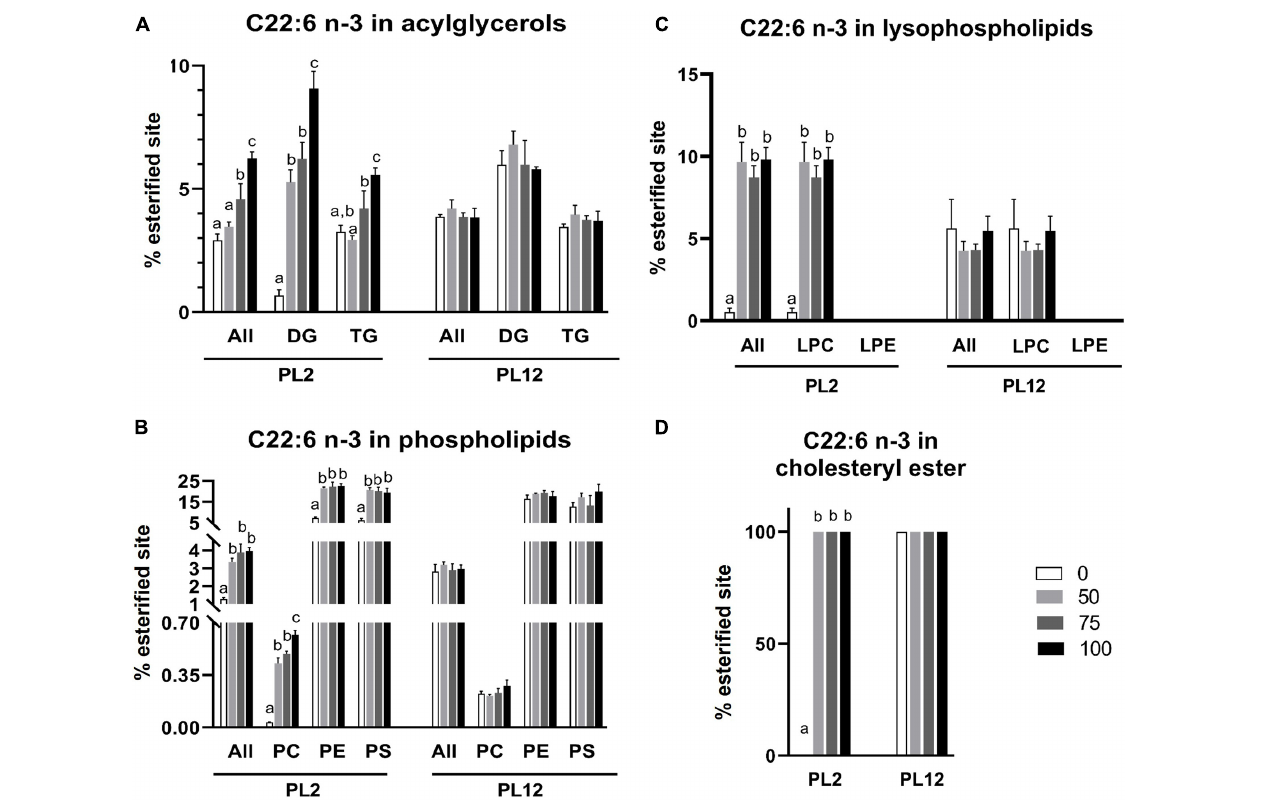
FIGURE 6 | Analysis of the 22:6 n-3 fatty acid distribution in lipid classes and subclasses by LC-HRMS. Percent of meal replacement was the percent of meals for which TW was replaced by AL. Percent esterified site is the percent of sites esterified with 16:0 compared with all the sites esterified with any types of fatty acids on the backbone. Error bars represent standard errors ( N = 3). Statistical analyses of the PL2 and PL12 data sets were performed separately, using ANOVA. Significant differences among subsets of treatment groups were determined by Duncan’s multiple range test ( P < 0.05); subsets with means not significantly different from one another are identified with the same letter above the bar. Bars with no specified letters mean no significant differences were identified among the groups ( P > 0.05).